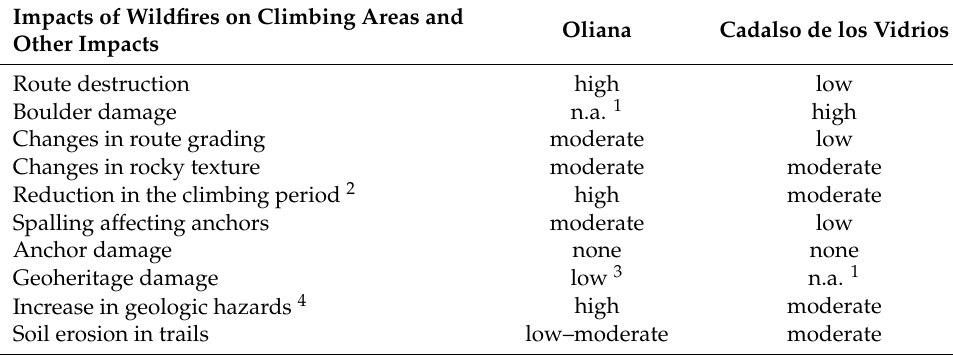
Table 5. Summary of effects of wildfires on the two studied climbing areas.